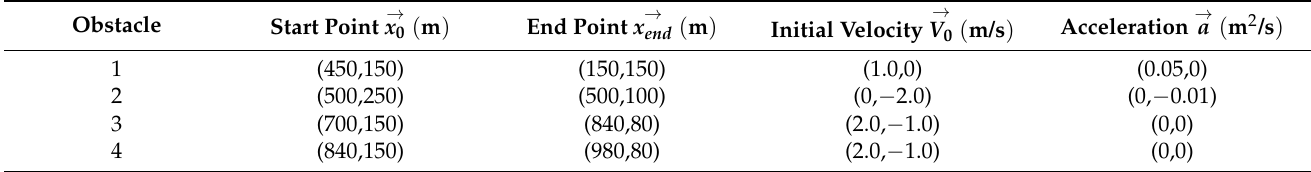
Table 5. Dynamic obstacles parameter information.